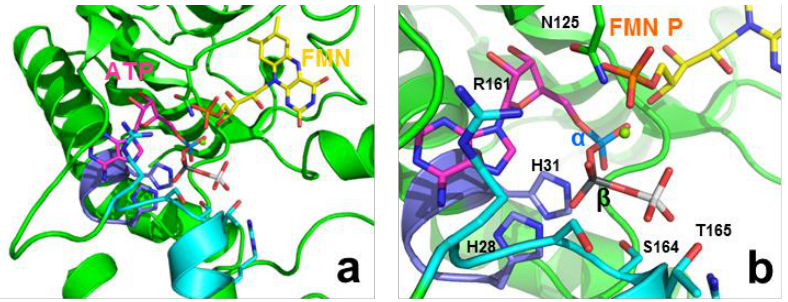
Figure 5. ( a ) Putative positioning of ATP, Mg 2+ and FMN substrates in the FMNAT-module of Ca FADS. Structure produced by comparing the Ca FADS crystal structure with those of the NMNAT from M. jannaschii (PDB code 1F9A) and M. thermoautotropicum (PDB code 1EJ2) in complexes with Mg 2+ : ATP and NAD + , respectively, and the FMNAT-module of Thermotoga maritima FADS in complex with AMP (PDB code 1T6Y). FMN and ATP are shown by sticks with carbons in yellow and magenta, respectively, while Mg 2+ is shown as a green sphere. The phosphate of FMN is shown in orange, while those of ATP are in blue (α), grey (β) and white (γ). ( b ) Model showing a putative organisation of the different phosphate groups at the catalytic